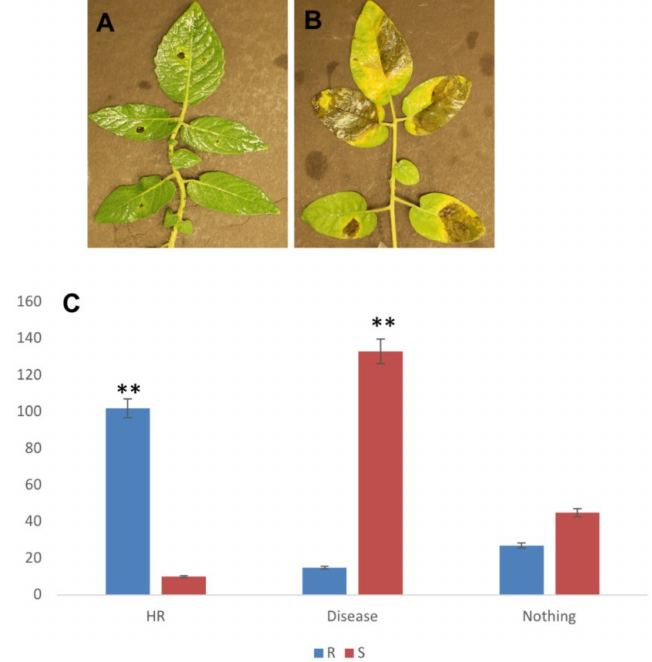
Figure 1. (A) Hypersensitive response (HR) on the leaves of S. pimpinellifolium accession (Sp-R) resistant to P. parasitica and (B) Disease symptoms on S. pimpinellifolium susceptible (Sp-S) accession in response to P. parasitica. (C) Disease and HR spots on Sp-S and Sp-R leaves after 72 h of P. parasitica inoculation. ** indicates p <